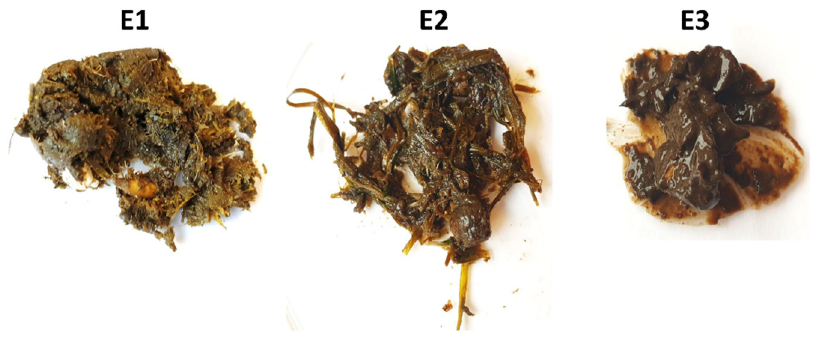
Figure 2. The dropping samples E1—E3 varying in texture and content of plant debris: E1—some plant debris, E2—mostly grass, E3—most likely cecal droppings, no plant